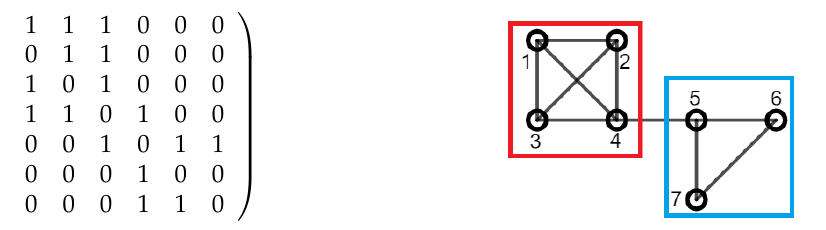
(cid:104) ∑ k ∑ = 1 A ( i , j ) − P i , j ∈ C r r = 1 2 m